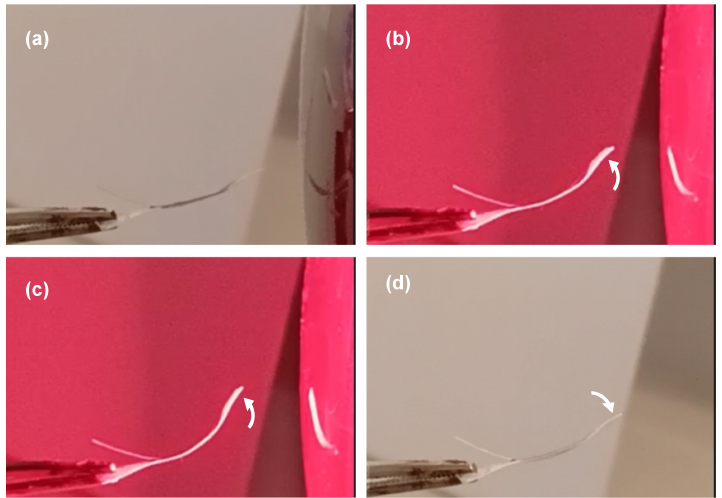
Figure 3. Frames taken at ( a ) 0, ( b ) 5 s, ( c ), 10 s, and ( d ) 180 s during the irradiation with an incoherent NIR red light. Arrows indicate the direction of bending.